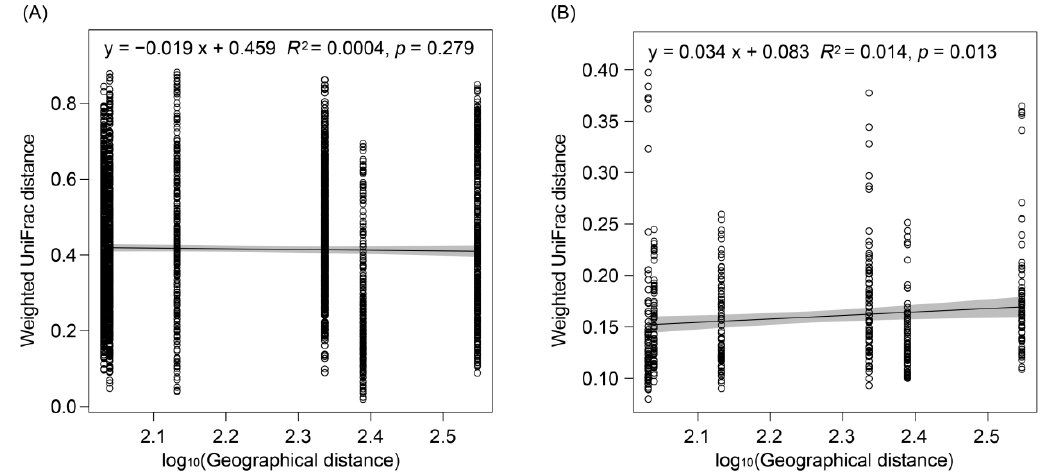
Figure 6. Changes in the UniFrac distances of the water microbiota ( A ) and Rhinogobio cylindricus gut microbiota ( B ) with geographical distance (km). The geographical distance represents the distance along the Yangtze River, not the straight-line distance. Geographic distances were converted into logarithm before the regression analysis.